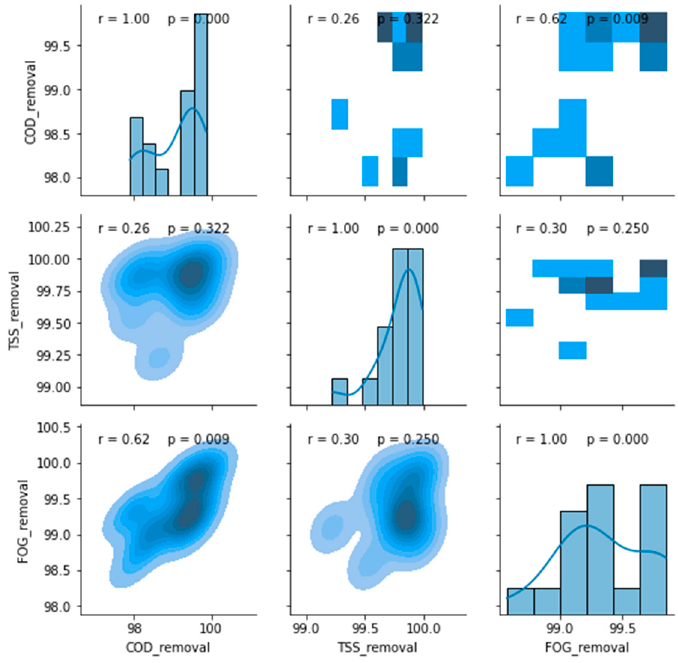
Figure 24. Correlation matrix between removal efficiencies of the combination of the pre-treatment stage, the DEGBR, and the MBR.